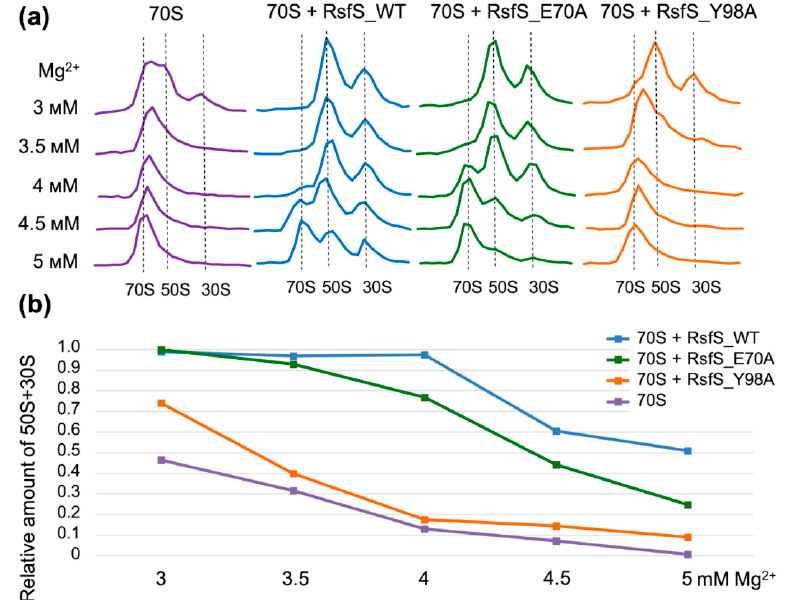
Figure 2. The influence of RsfS amino acid substitutions on ribosomal subunit dissociation at different concentrations of Mg 2+ . ( a ) Sucrose gradient profiles of the vacant 70S ribosomes with the wild-type RsfS (WT) and its mutants at different concentrations of Mg 2+ . ( b ) The relative amount of dissociated ribosomal 50S + 30S subunits (peak squares under the sucrose gradient profile) to the full number of subunits (50S + 30S + 70S) depending on the magnesium concentration.